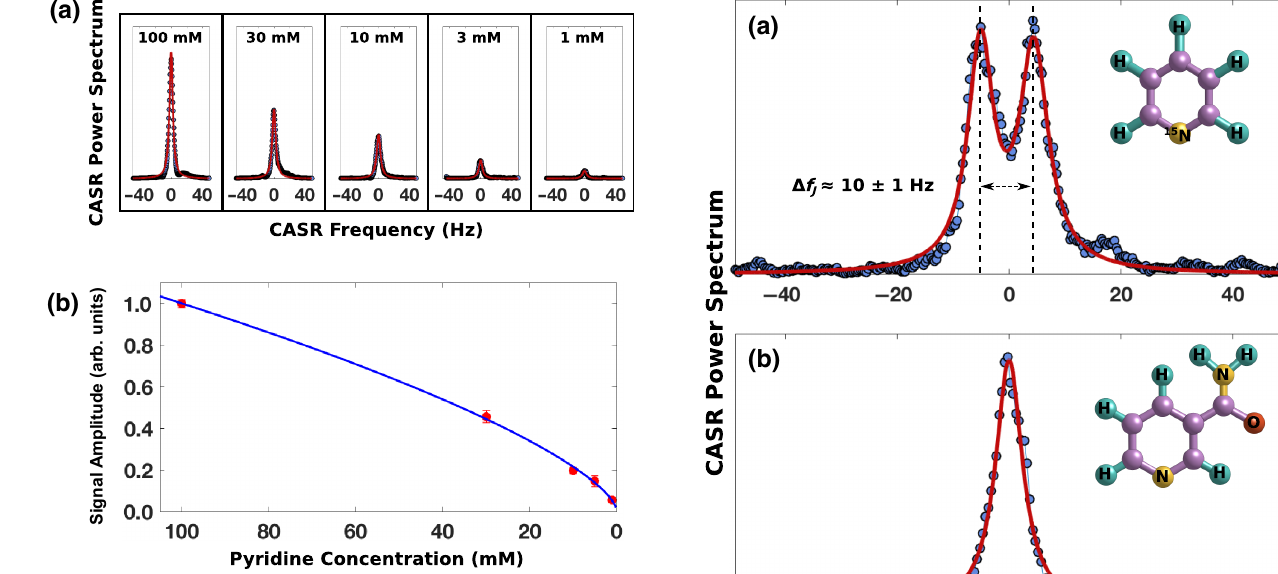
FIG. 3. SABRE-enhanced NV-NMR measurement for various pyridine concentrations. (a) CASR-detected NV-NMR spectra (blue circles) for hyperpolarized pyridine samples and the asso- ciated Lorentzian fits (solid red line) at concentrations of 100, 30, 10, 5, and 1 mM in methanol. (b) CASR-detected NV-NMR signal amplitude (red dots) of hyperpolarized pyridine at various concentrations. The solid blue curve is a power function model of the form ax b + c with fit parameters a = 0.042, b = 0.6855, and c = 0.012.